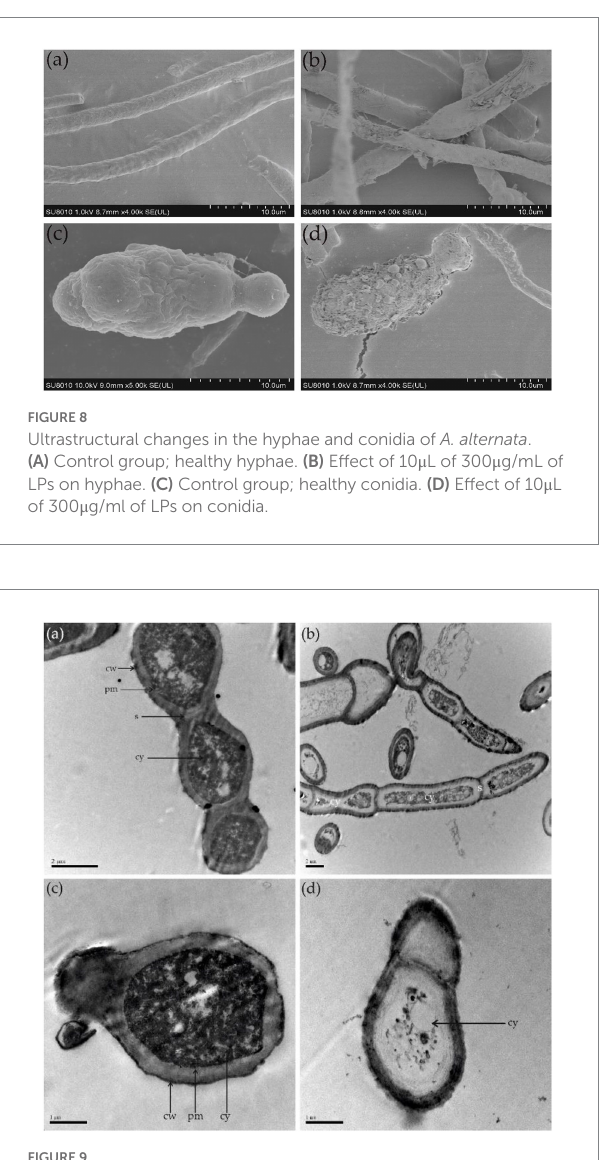
FIGURE 9 Transmission electron microscopy. (A) Control group; healthy hyphae. (B) Hyphae treated with 10 μ l of 300 μ g/ml of LPs. (C) Healthy conidia. (D) Conidia treated with 10 μ L of 300 μ g/mL of LPs. cw, cell wall; cy, cytoplasm; pm, plasma membrane; s,